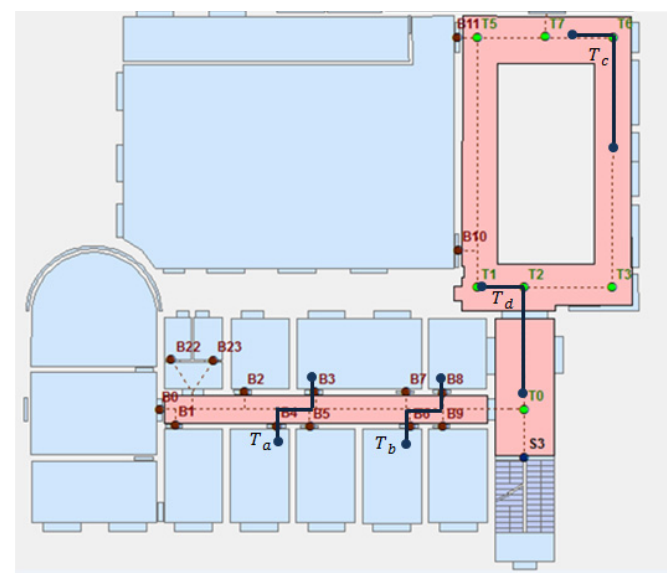
Figure 13. Examples of short trajectories.